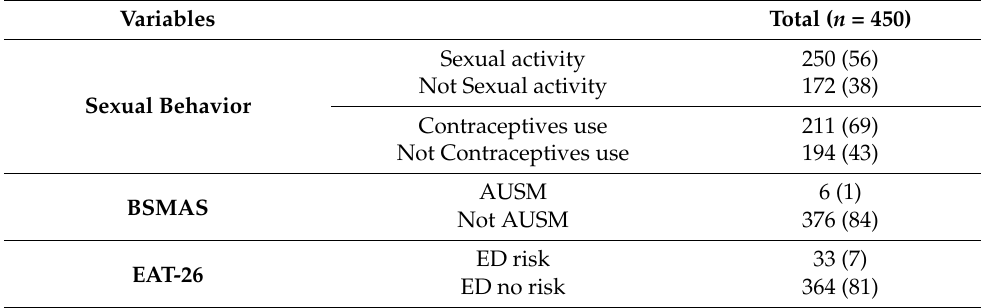
Table 2. Frequency of risk behaviors in total